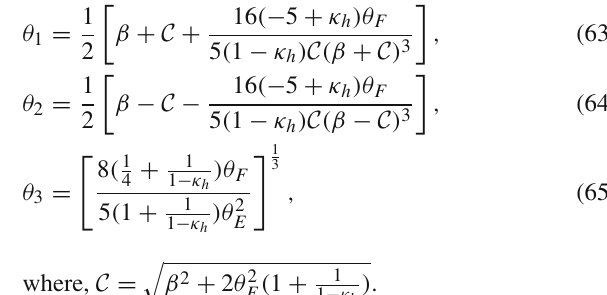
Fig. 9 Homogeneous case: In the first row, the variation of total mag- nification ( μ tot ) for homogeneous distribution of plasma with dimen- sionless “Hoˇrava” parameter ( ˜ ω ) for different combinations of angle KS of source from observer-lens axis ( β ) and plasma parameter keeping θ = 0 . 4472 constant. In the second row, the variation of total mag- E